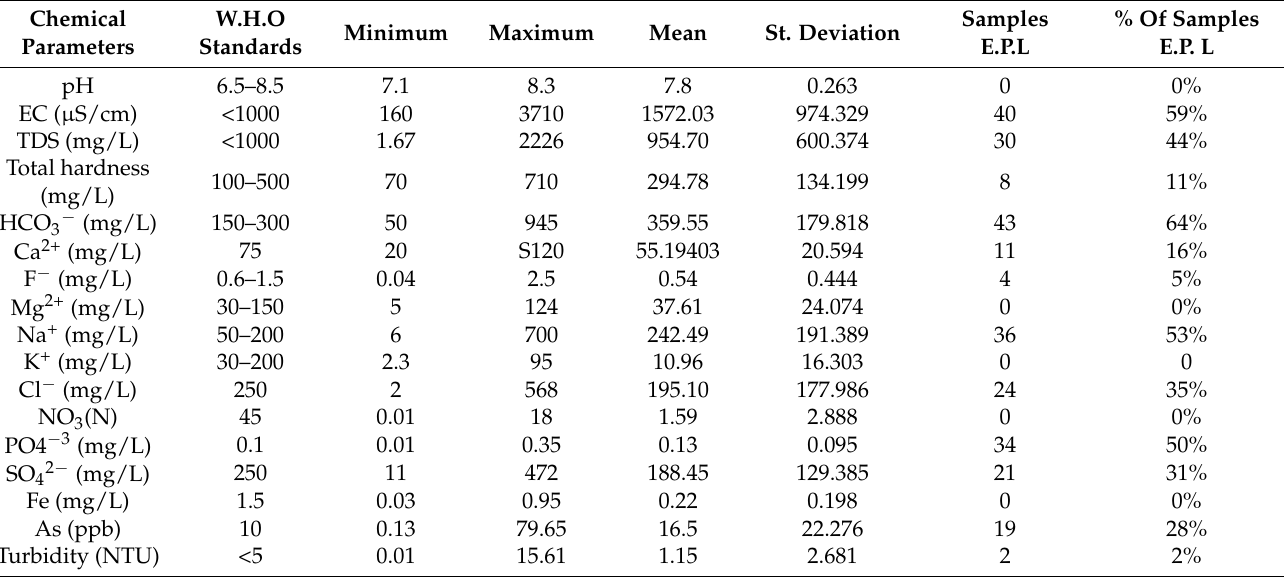
Table 1. Descriptive statistics of groundwater samples